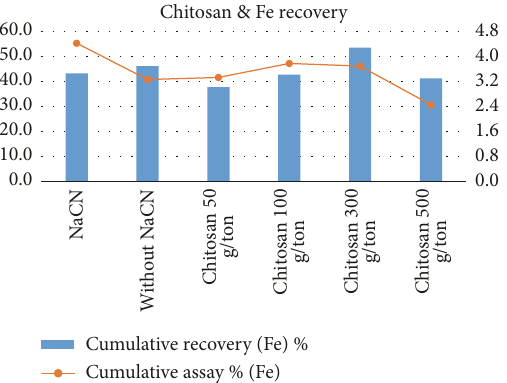
Figure 9: Iron recovery and concentrate grade as a function of chitosan dosage in comparison with NaCN depressant.